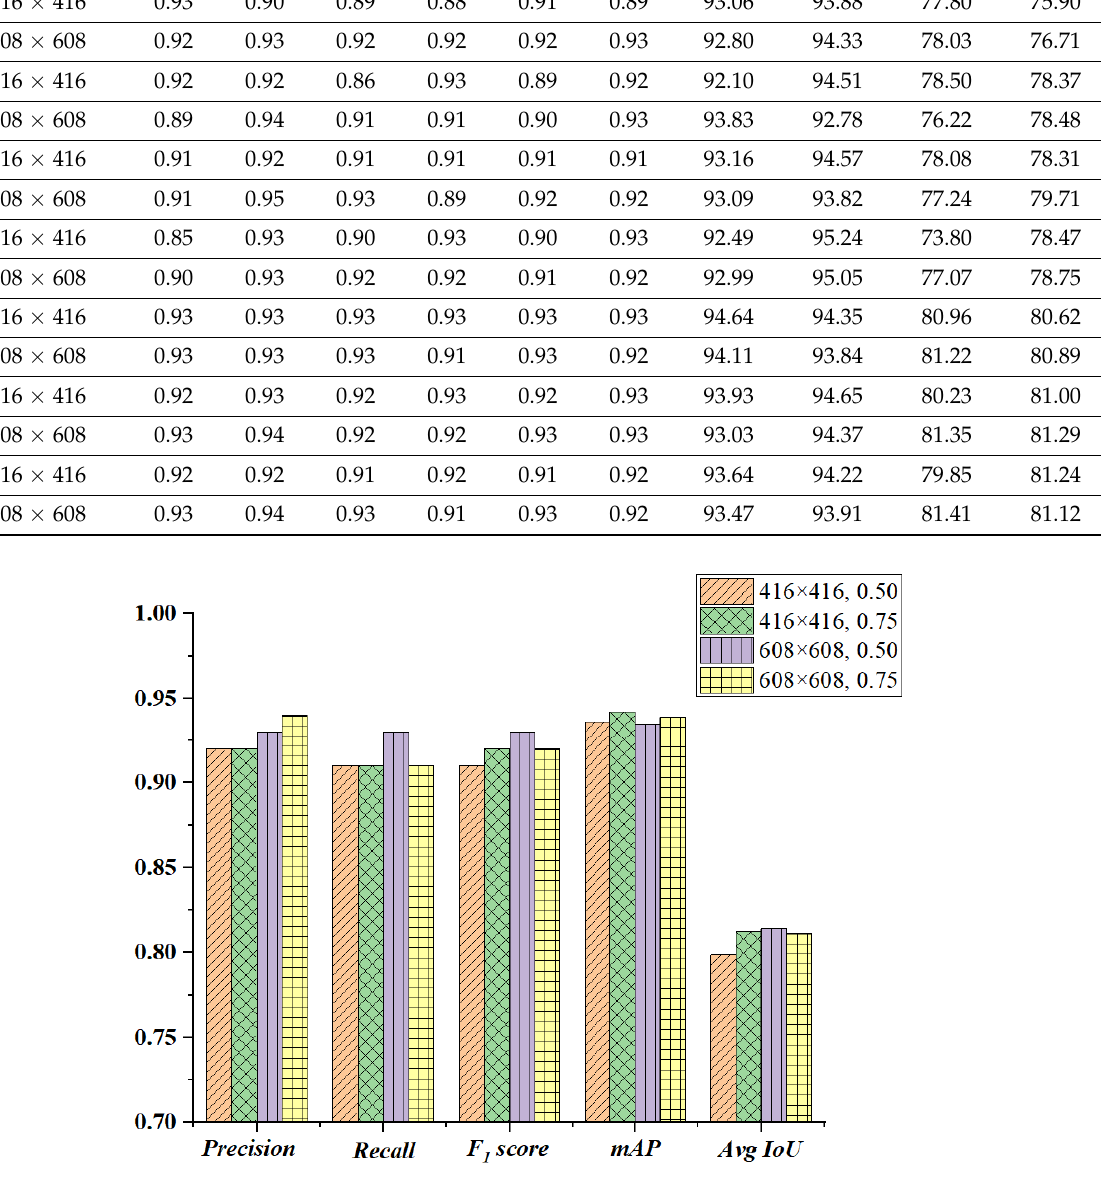
Figure 12. Comparison between different evaluation metrics.